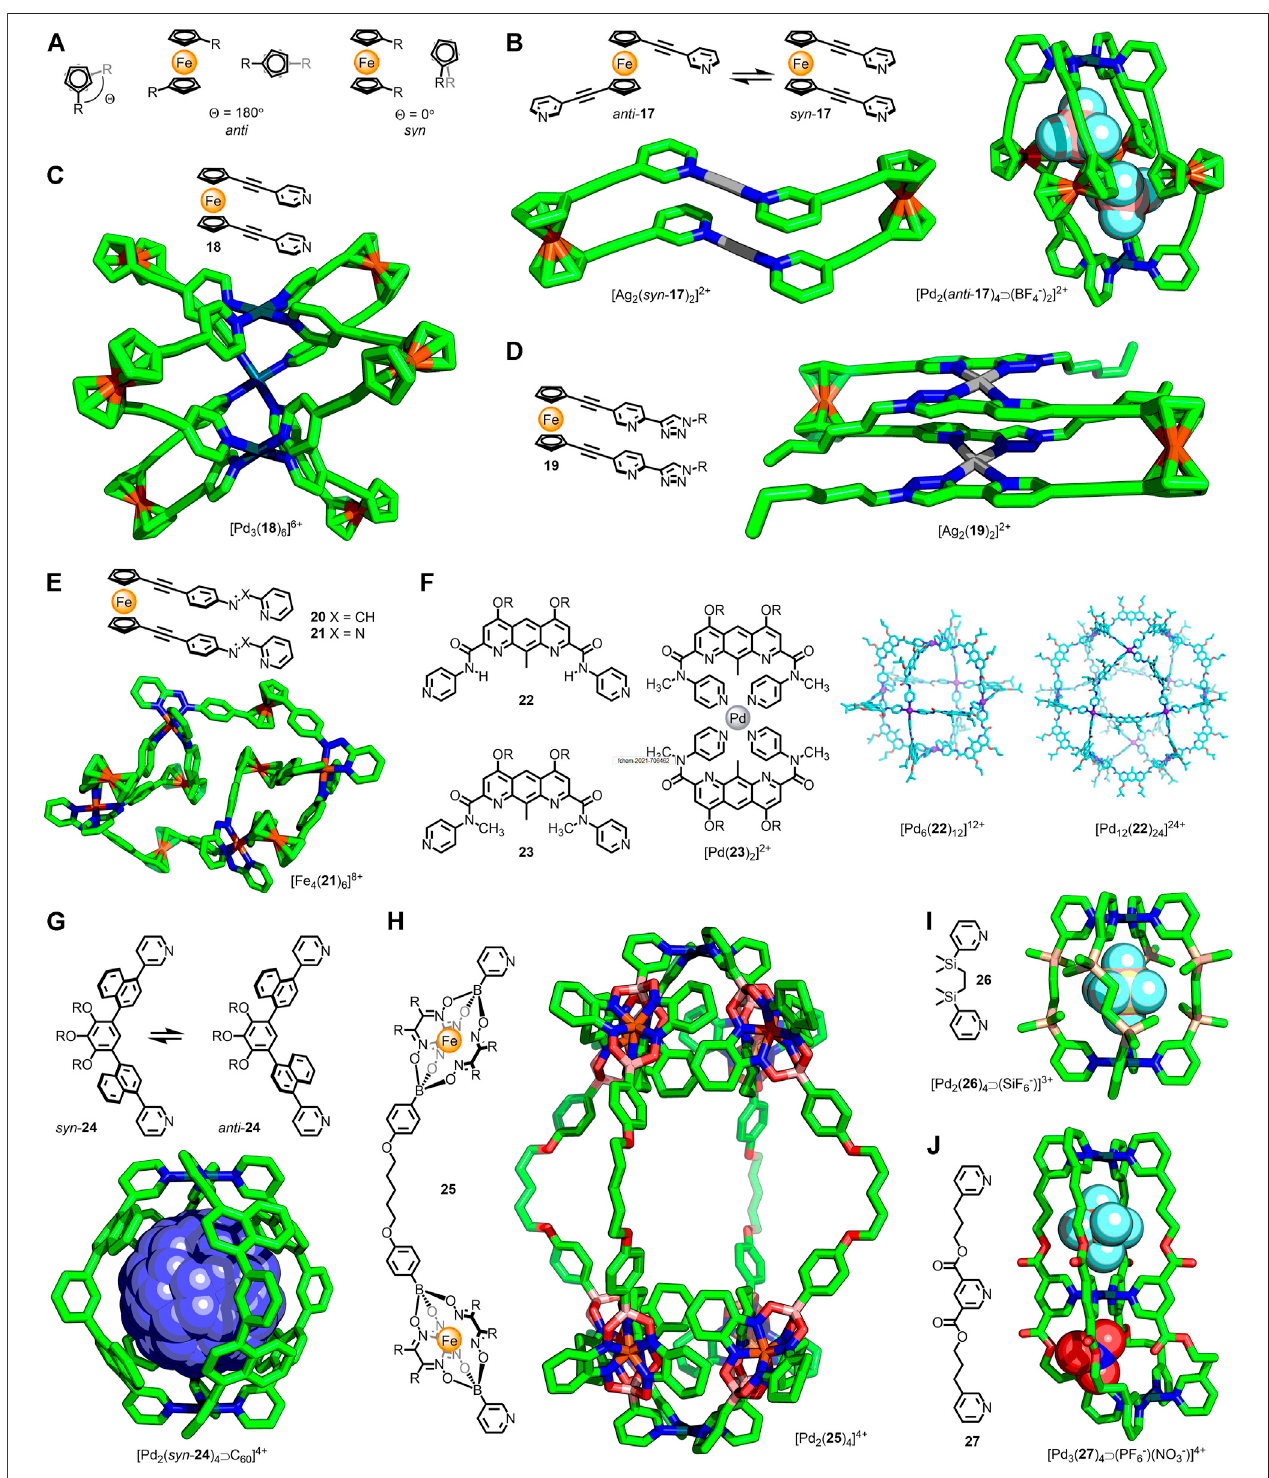
FIGURE3|(A) Thecyclopentadieneringsofferroceneareabletoundergo360 ° rotation.Thetwoextremes ofconformationarethe anti ( Θ (cid:2) 180 ° )and syn ( Θ (cid:2) 0 ° ) conformers. (B) In the dinuclear metallacycle [Ag 2 ( 17 ) 2 ] 2+ ligand 17 is observed to adopt a syn conformation; in the quadruple-stranded [Pd 2 ( 17 ) 4 ] 4+ cage the anti conformerisobserved. (C) Crowley ’ strigonalprismatic[Pd 3 ( 18 ) 6 ] 6+ assemblywithligandsin syn arrangements( Θ (cid:2) 25 – 42 ° ). (D) Adinuclearmetallacycle,[Ag 2 ( syn - 18 ) 2 ] 2+ reportedbyCrowley. (E) Nitschke ’ stwistedparallelogramassembly,withligand 21 inboth syn and anti conformations. (F) Non-covalentinteractionsaffectfavouredligand conformations:self-assemblywithPd(II)ledtoaPd 12 L 24 cuboctahedronwith 22 ( via akineticPd 6 L 12 cube;calculatedstructuresshown),whilstligand 23 givesthemononuclear